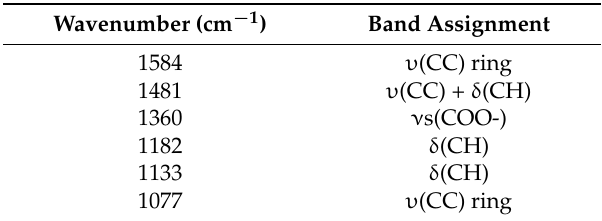
Table 1. Raman band frequencies of